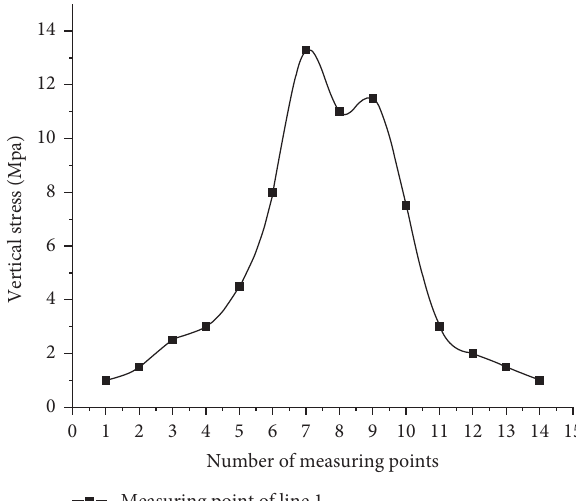
Figure 11: Pressure distribution curve of line